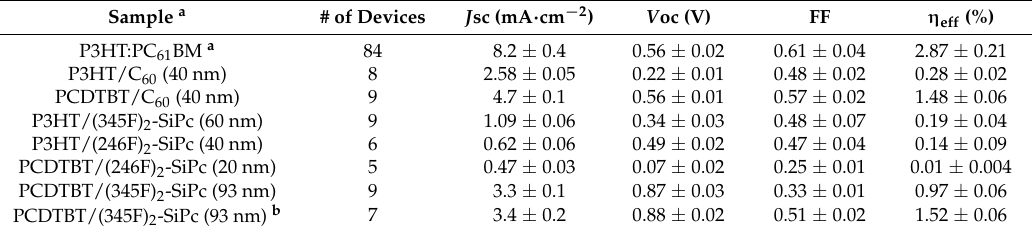
Figure 1. Chemical structure of poly[N-9 (cid:48) -heptadecanyl-2,7-carbazole-alt-5,5-(4 (cid:48) ,7 (cid:48) -di-2-thienyl-2 (cid:48) ,1 (cid:48) , 3 (cid:48) -benzothiadiazole)] (PCDTBT), poly(3-hexylthiophene) (P3HT), fullerene (C 60 ), bis(3,4,5-trifluorophenoxy) silicon phthalocyanine ((345F) 2 -SiPc) and bis(2,4,6-trifluorophenoxy) silicon phthalocyanine ((246F) 2 -SiPc), and the mixed solution/evaporation planar heterojunction (PHJ) organic photovoltaic (OPV) device structure. Table 1. Characterization of fullerene-based devices, both the bulk (BHJ) and planar heterojunction (PHJ), and the silicon phthalocyanine-based mixed solution/evaporation PHJ OPV device. Sample